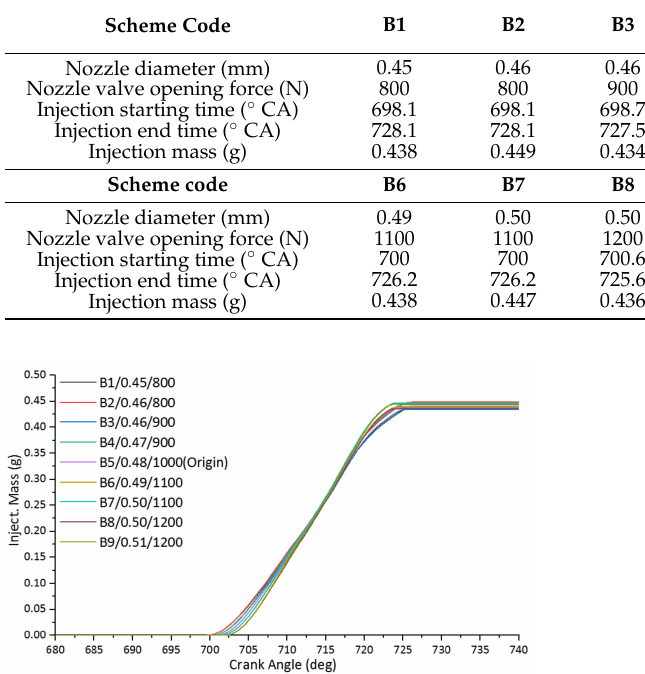
Figure 24. Effect of needle valve opening pressure and nozzle diameter on mass, pressure and SMD. Table 4. Pre-selection scheme of fuel injector structure.